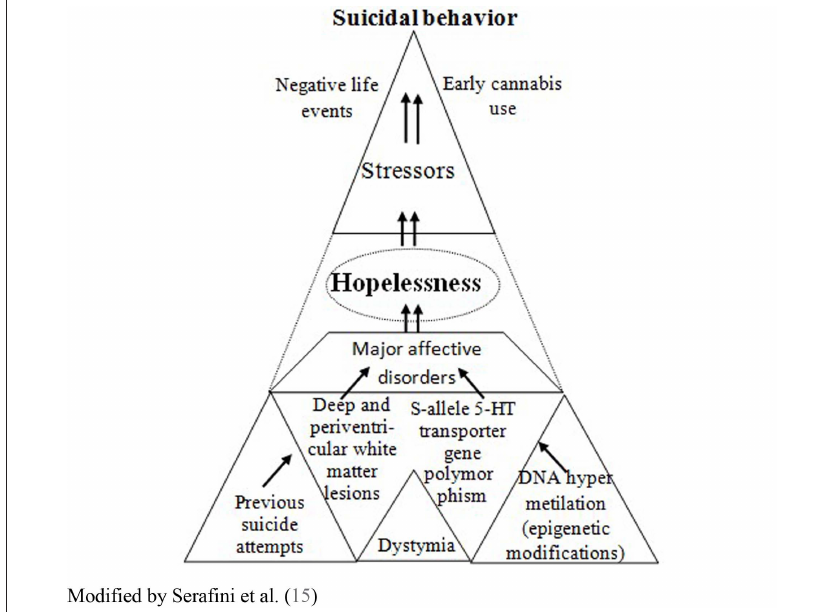
Figure 1 | The complex interaction between risk factors involved in the emergence of suicidal behavior: the mediating effect of